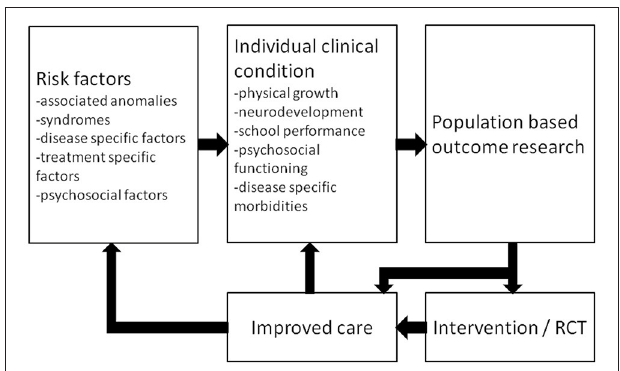
FIGURE 2 | Schematic representation of a standardized multidisciplinary approach to optimize care. RCT = randomized controlled trial. Reprinted from Sem Pediatr Surg, Vol 26, IJsselstijn H et al., Assessment and significance of long-term outcomes in pediatric surgery, Pages 281–285, Copyright 2017, with permission from